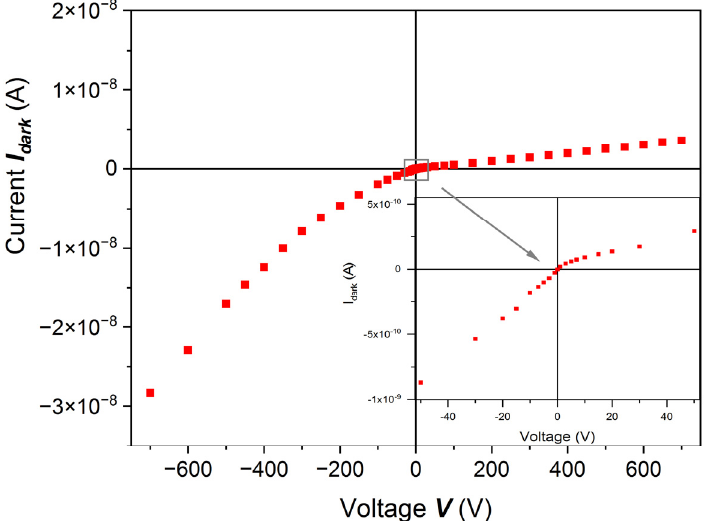
Figure 5. Room-temperature dark I-V characteristic for a (Cd,Mn)Te:In sample cut parallel to the (111) plane. After preliminary preparation, the sample was etched with 20% HCl. The contacts were sputtered Pt/Pd layers. The current is much lower when the anode is on the cadmium surface (A), especially at high bias voltage.